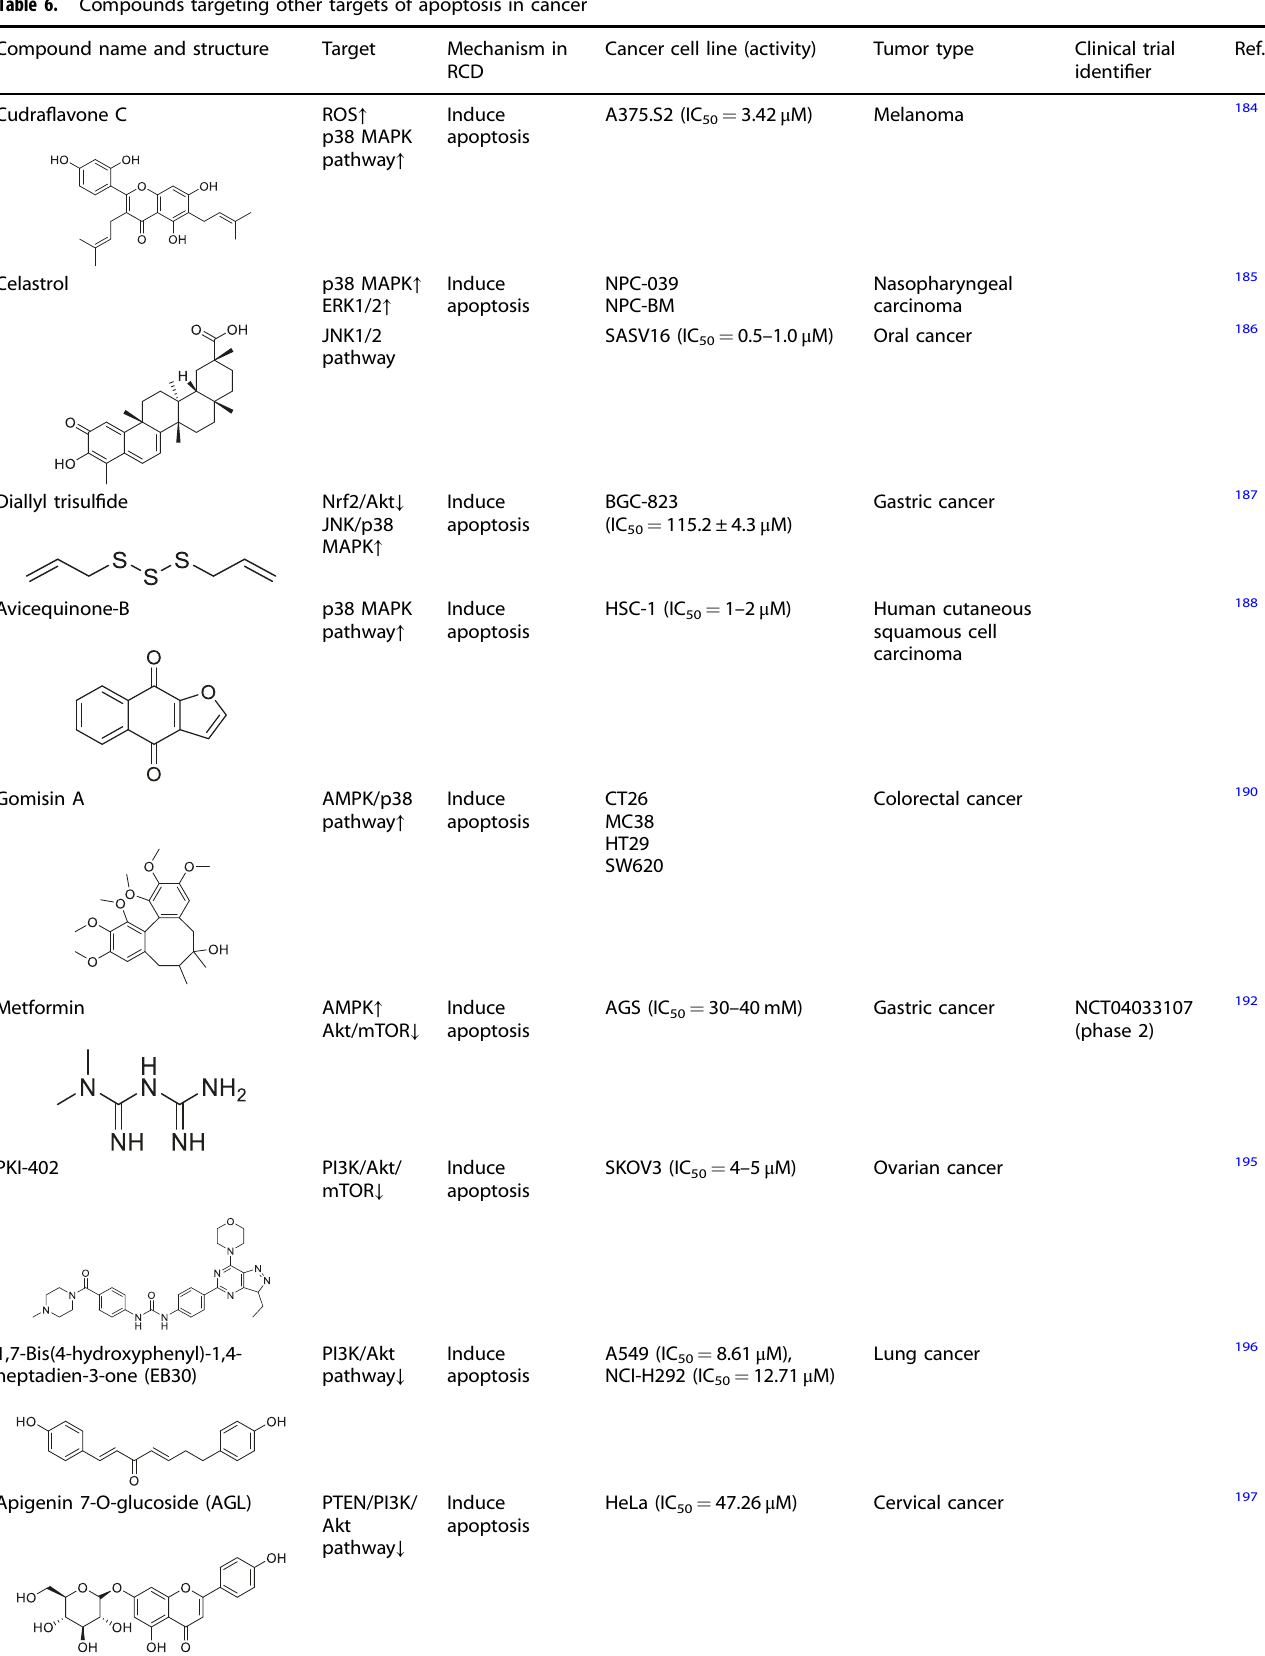
Table 6. Compounds targeting other targets of apoptosis in cancer Compound name and